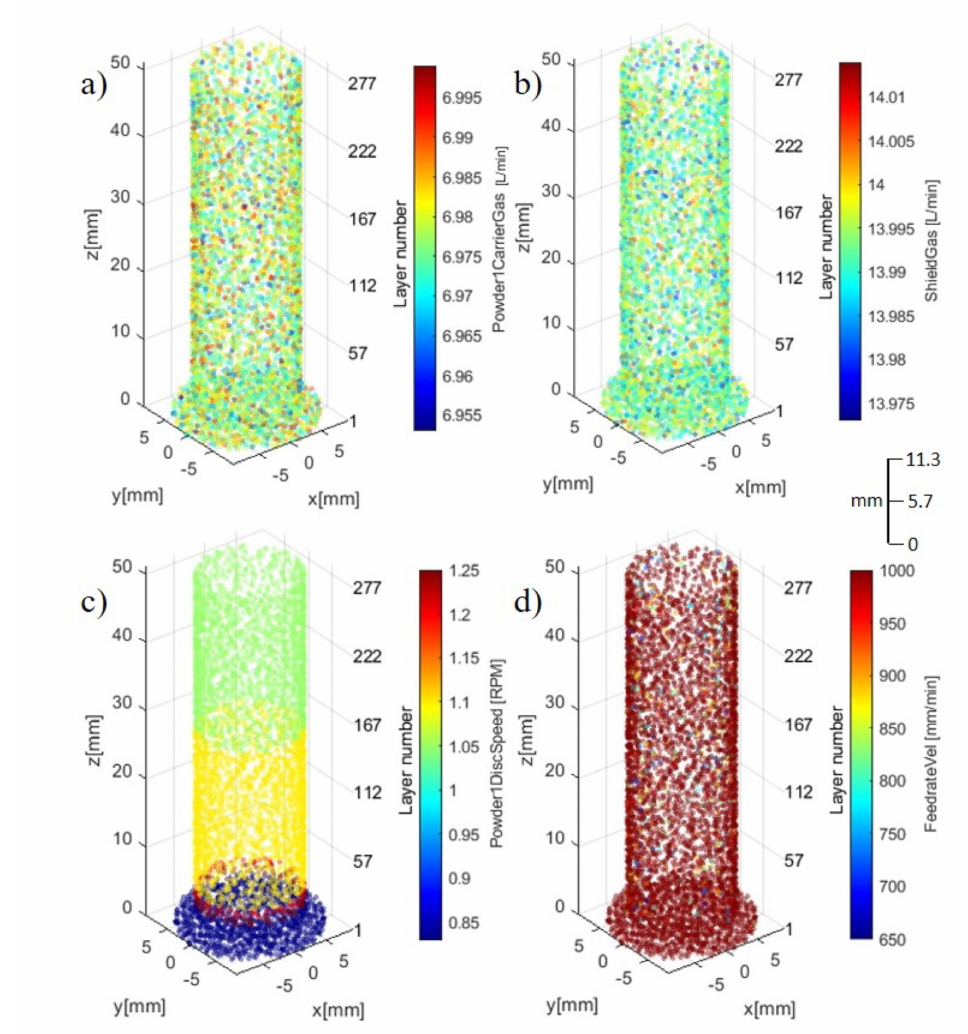
Figure 5. Synchronously collected process parameters: ( a ) PCG, ( b ) SG, ( c ) PDS, and ( d ) FR.